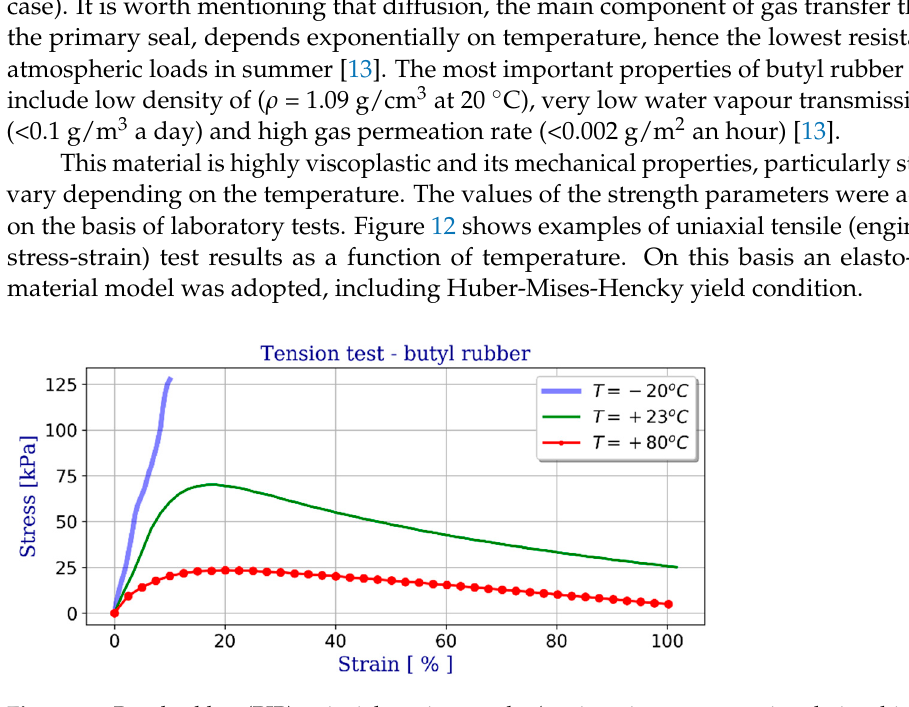
Figure 12. Butyl rubber (PIB) uniaxial tension results (engineering stress–strain